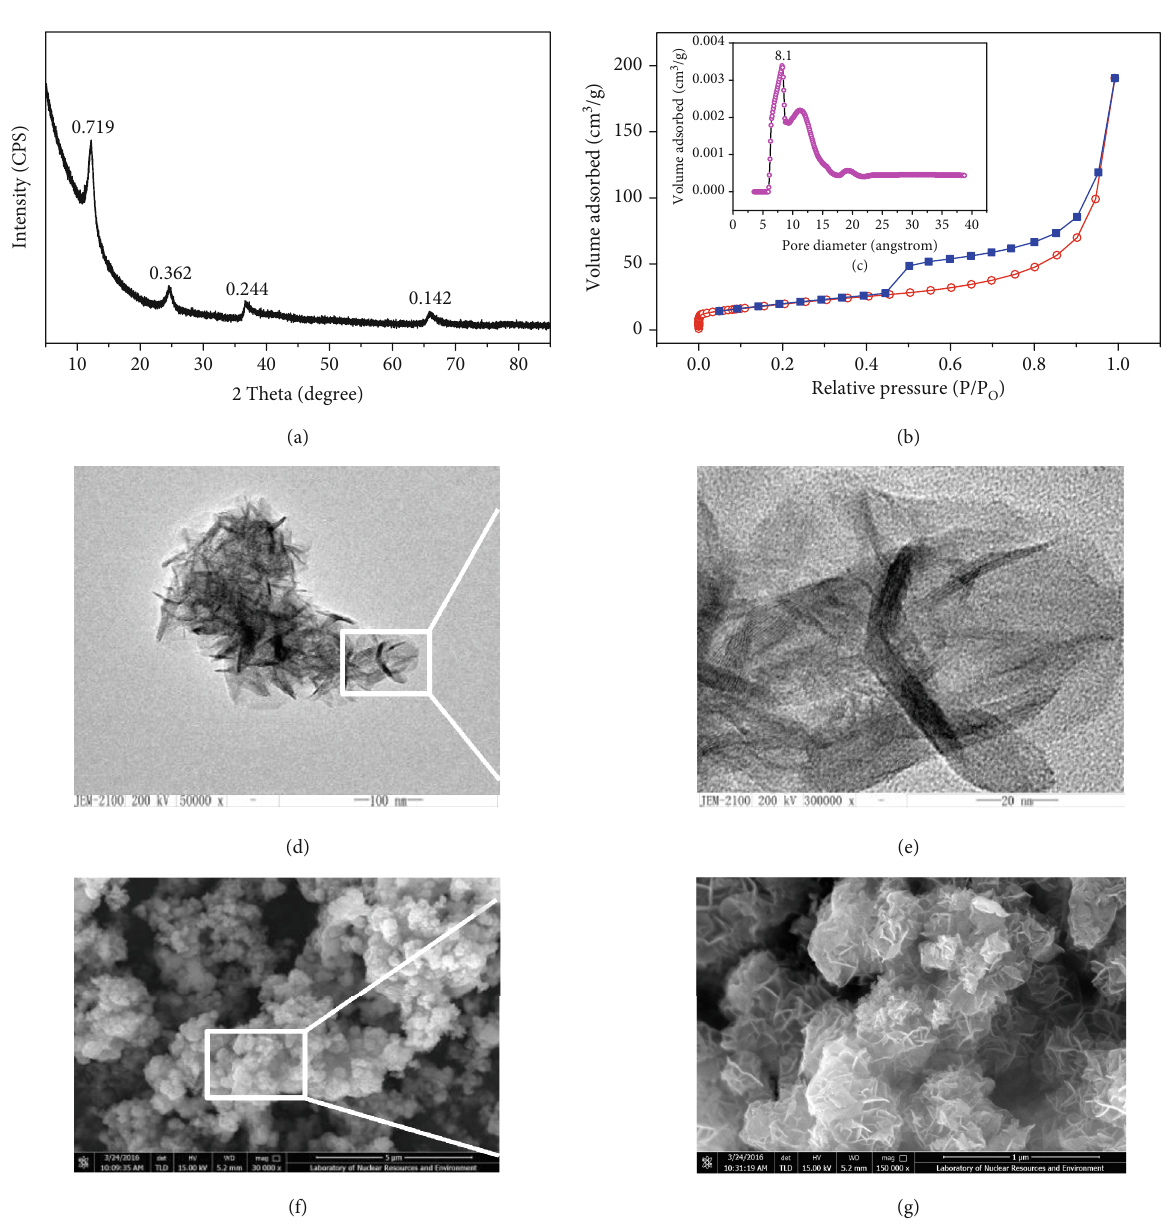
Figure 1: The XRD pattern (a) of δ -MnO distribution plot (c) by the SF method; HRTEM (d, e) and HRSEM (f, g) images of δ -MnO